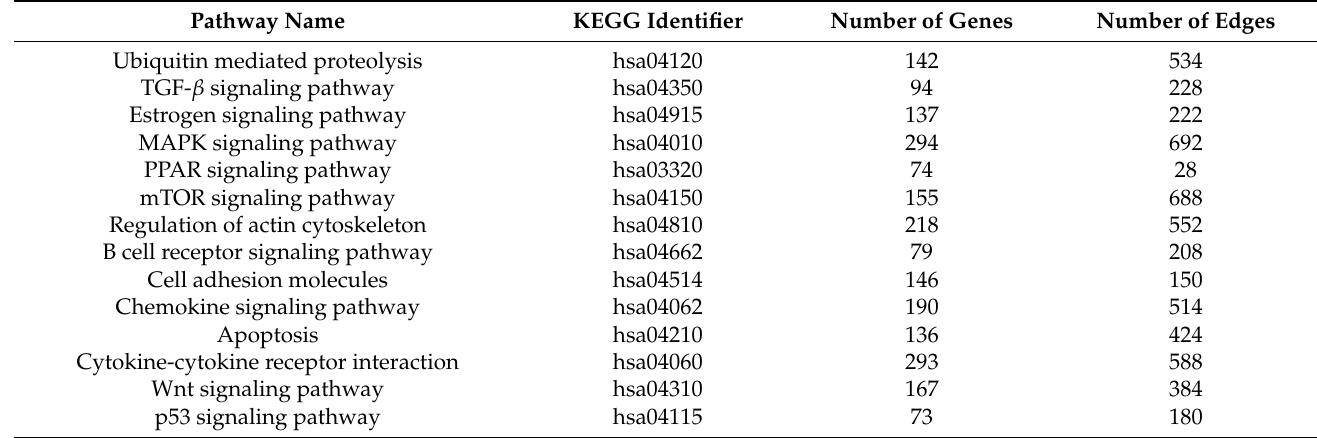
Table A1. A list of cancer-related pathways used as subgraphs in the cell-line template